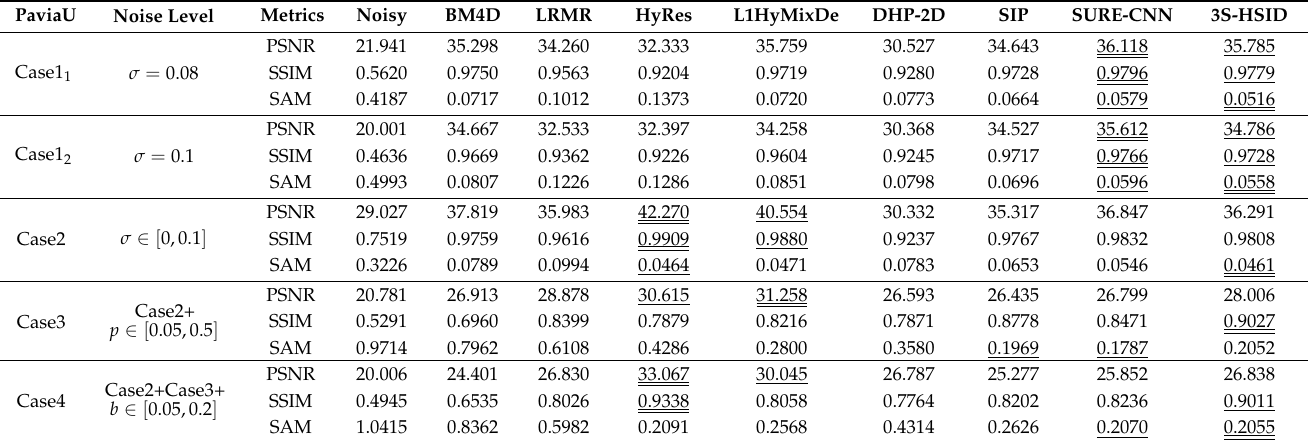
Table 2. Denoising results of PaviaU hyperspectral simulation